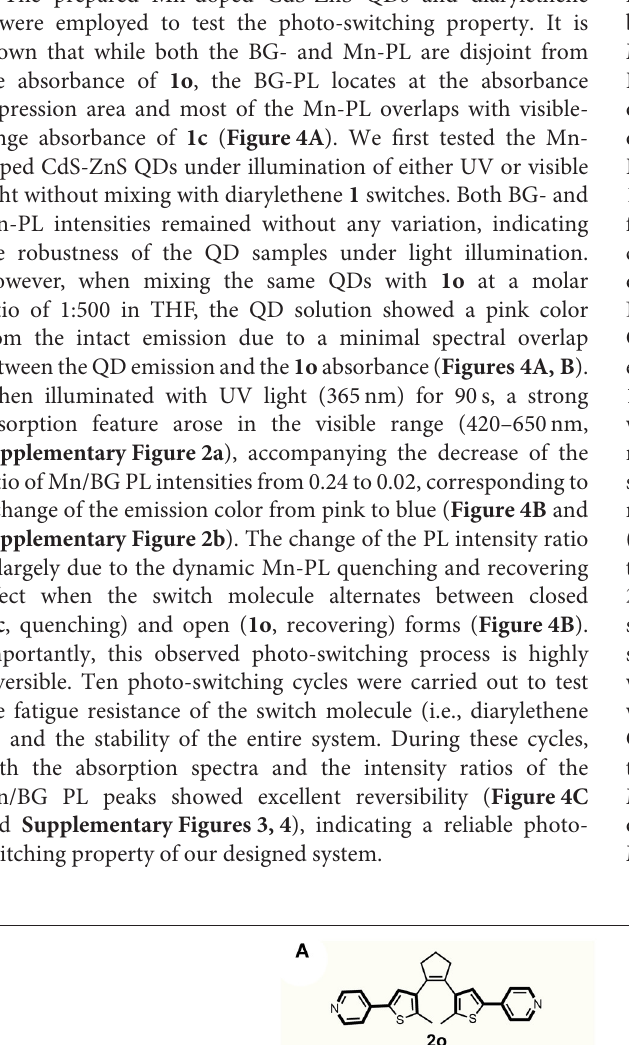
Frontiers in Chemistry |